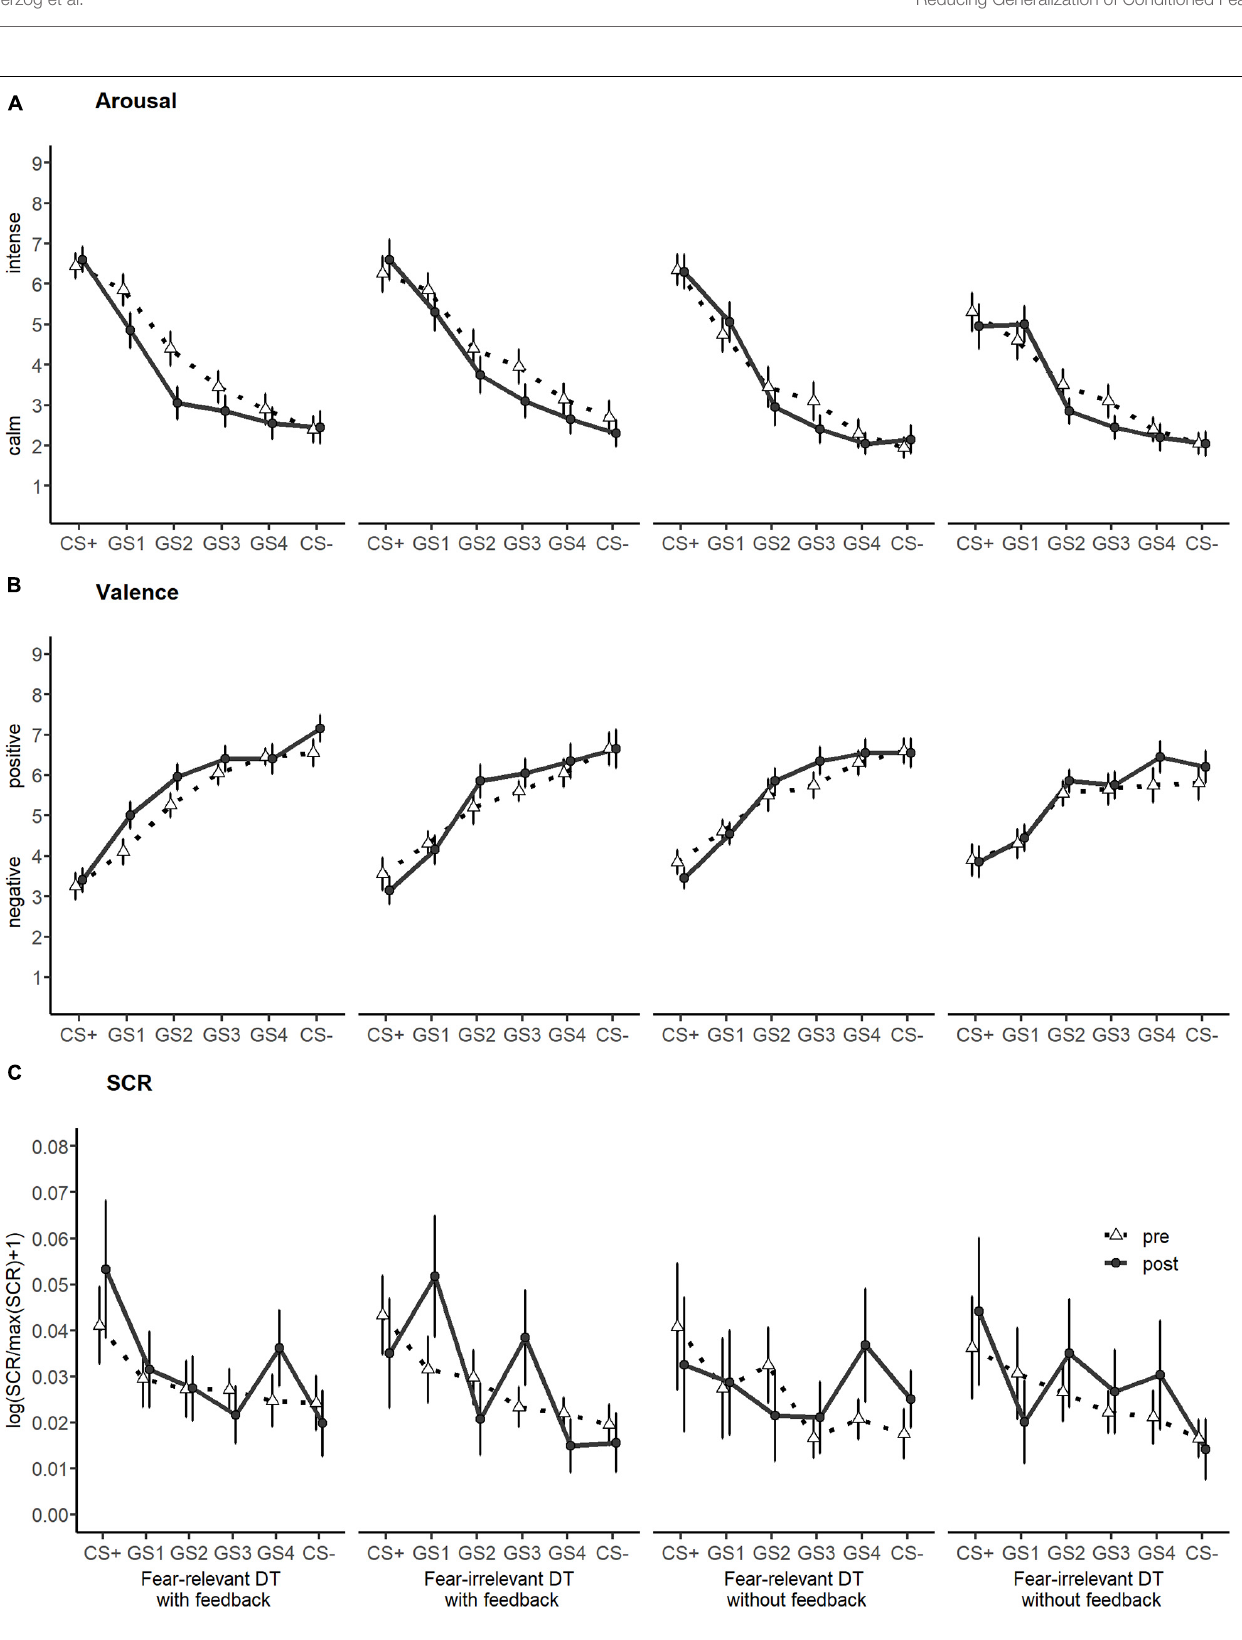
Frontiers in Psychology |